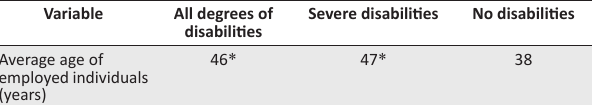
TABLE 3: Average age of employed individuals aged 15–59